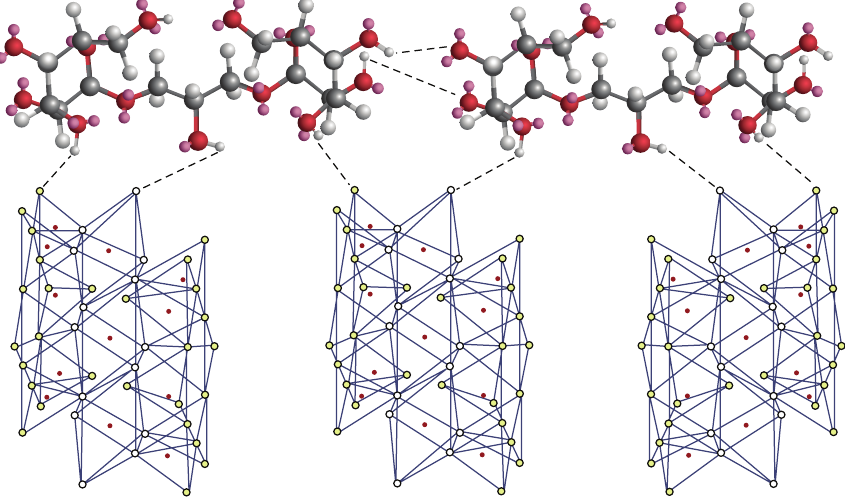
Figure 10: The possible interaction of BG and